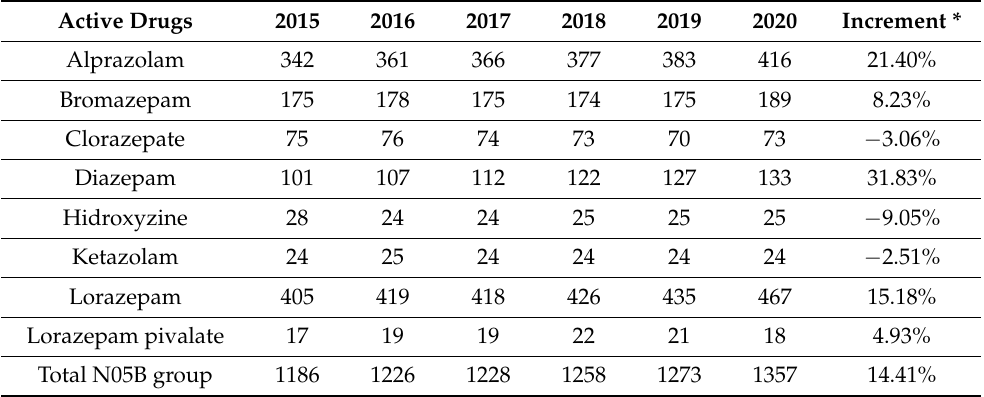
Table 1. Progression of the anxiolytics dispensed in Castile and Leon (packs/1000 inhabitants) dur- ing 2015–2020.